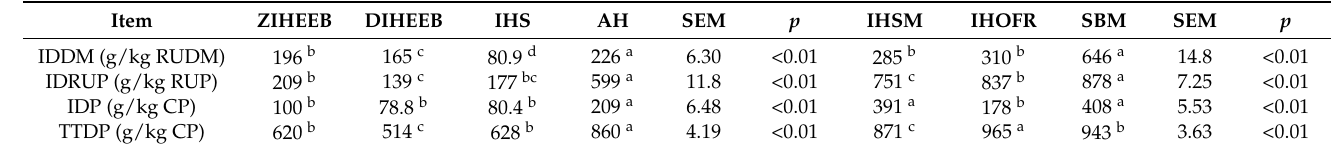
Table 4. The intestinal degradation ratio of industrial hemp byproducts and conventional